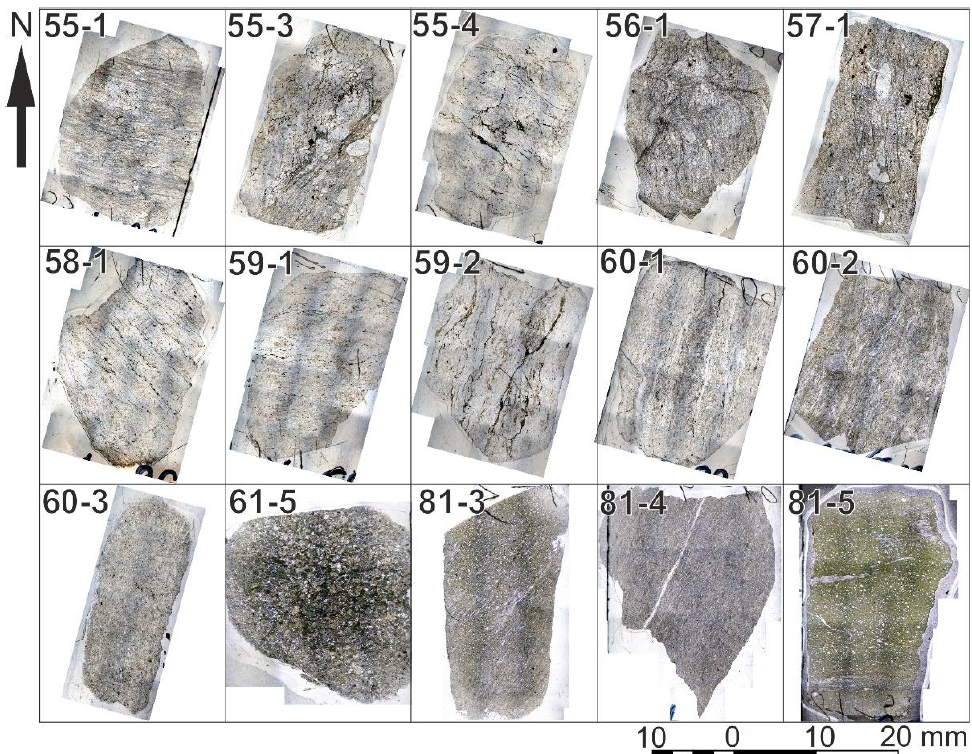
Figure 3. Images of the studied oriented thin sections obtained using the Olympus BX-51 optical microscope with the Olympus Camedia C7070zoom digital camera.